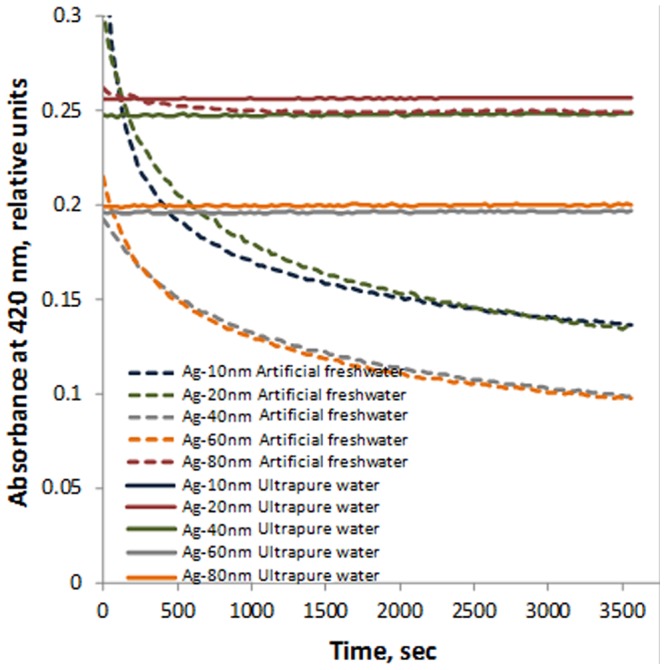
Sedimentation of Ag NPs in ultrapure water and in artificial freshwater during 60Concentrations of Ag NPs were: Ag-10 nm 8 mg/L, Ag-20 nm 11 mg/L, Ag-40 nm, Ag-60 nm and Ag-80 nm 5 mg/L. Decreased absorption of light (420 nm) by Ag particles in artificial freshwater (test medium for D. magna) (dotted line) is due to settling over time. In ultrapure water (solid line) no decrease in absorption was observed.